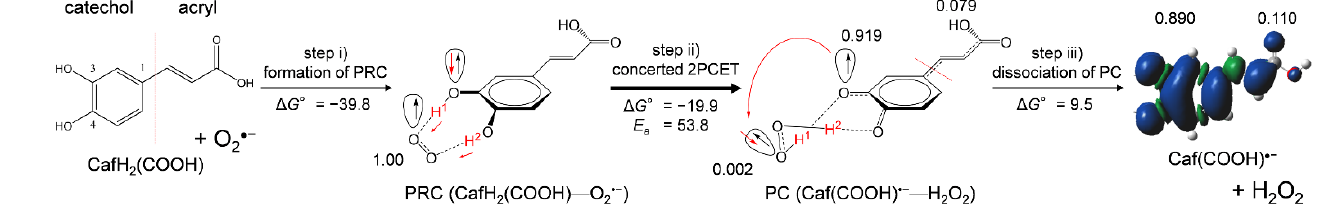
Figure 8. Net PCET mechanism between CafH 2 (COOH) and O 2• − in DMF with the Δ G ° and E a values (kJ mol − 1 , 298.15 K). Step i) initial formation of PRC; step ii) concerted 2PCET; step iii) dissociation of the PC. Δ G ° and E a were calculated using the DFT-(U)B3LYP/PCM/6-311+G(3df,2p) method. The numbers are spins distributed on the oxygen species (O 2• − , H 2 O 2 ), the CatH 2 moiety, and the acryloyl group obtained by NBO analysis.